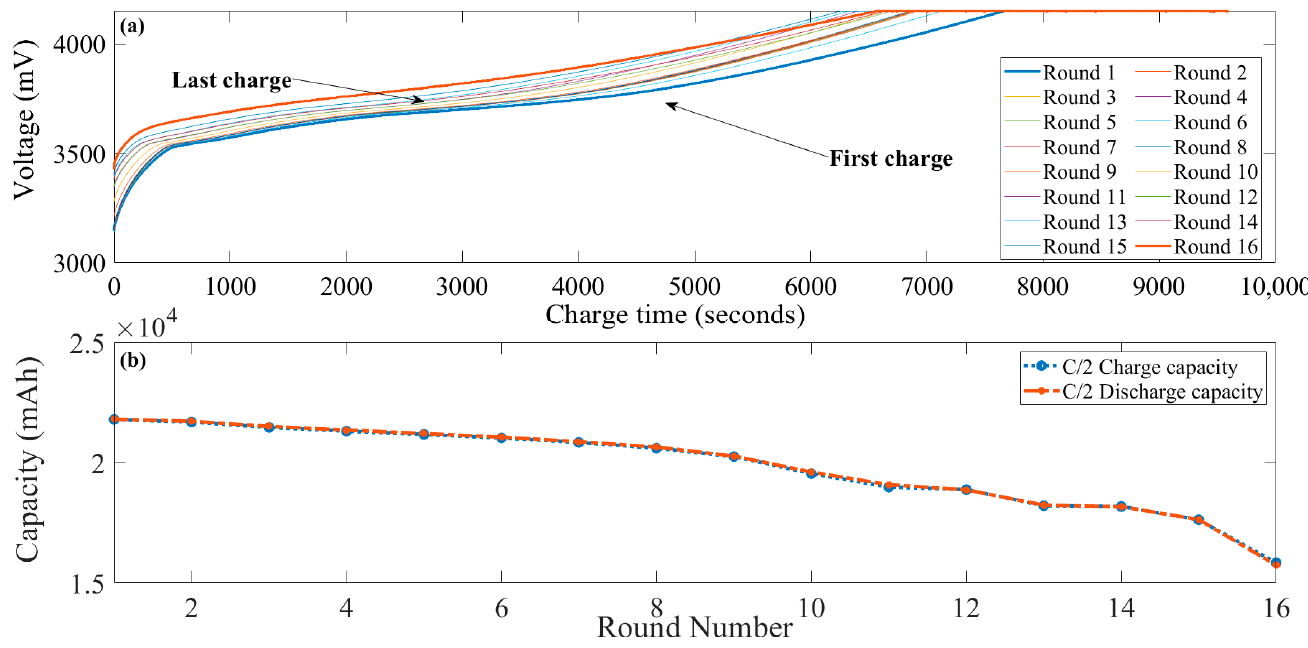
Figure 3. ( a ) Charge-voltage decrease by time (LLI); ( b ) Last cycle’s charge-discharge capacity comparison at each round during the